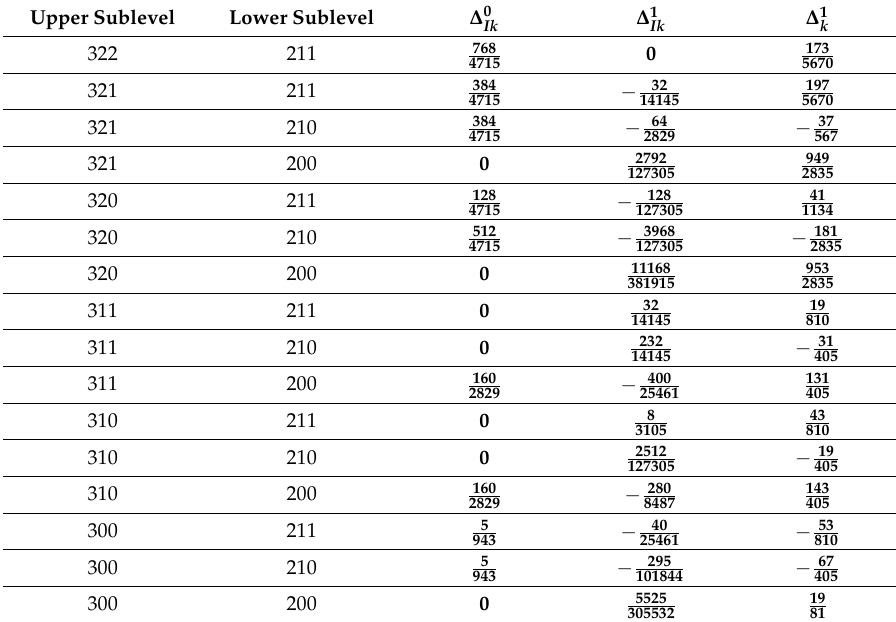
Table A1. Corrections to the intensity and frequency of the He II Balmer-alpha line components. Upper